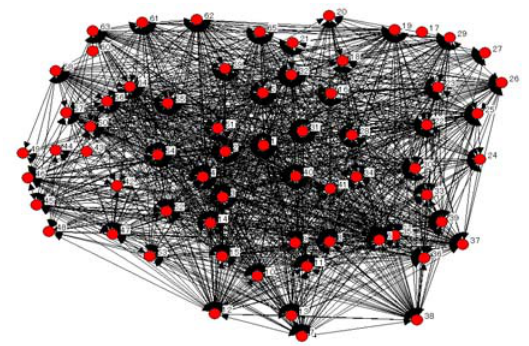
Figure 2. Item network